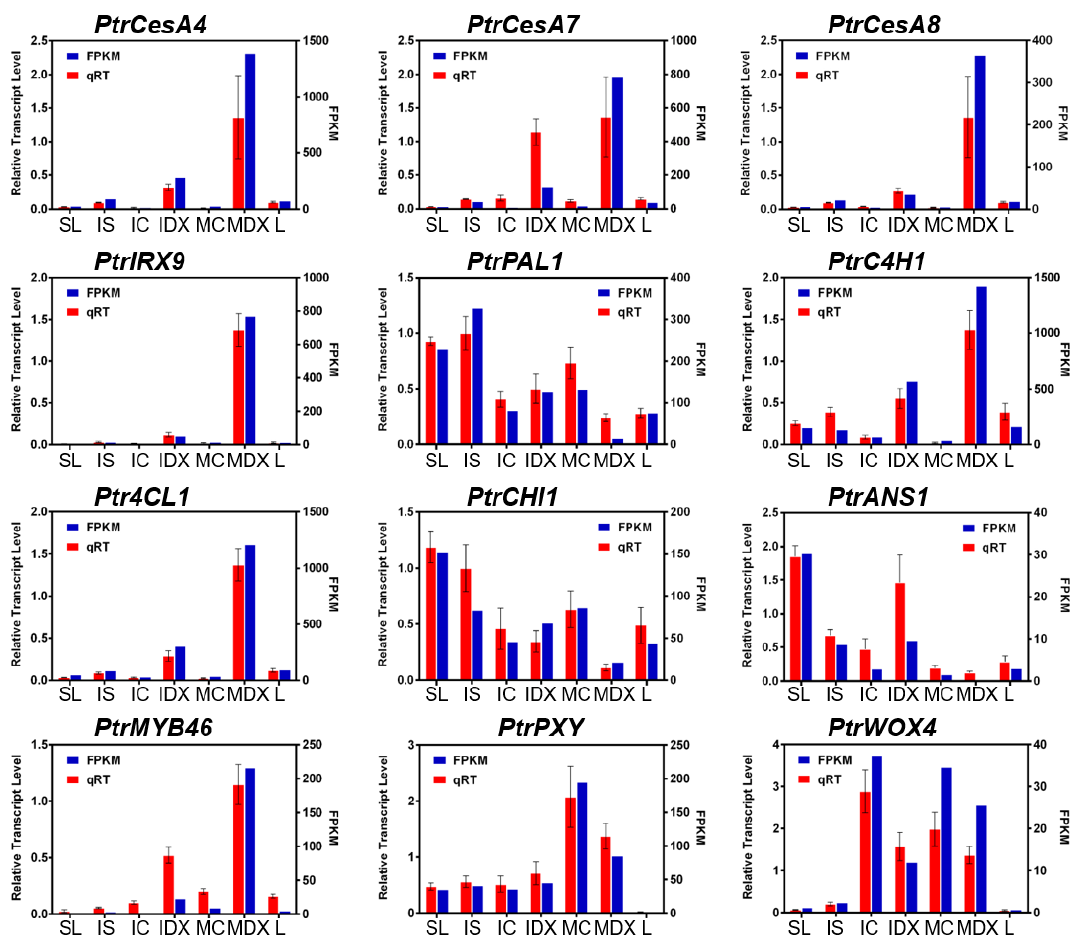
Figure 2. Confirmation of RNA-seq results by independent qRT-PCR analysis. Expression of each indicated gene is plotted. In each plot, blue bars (right Y-axis) indicate FPKM (Fragment Per Kilobase of transcript per Million mapped reads) values from RNA-seq data while red bars (left Y-axis) indicate qRT-PCR results. A gene model name for P. trichocarpa (v3.0) is shown in parenthesis as: PtrCesA4 (Potri.002G257900.1); PtrCesA7 (Potri.018G103900.1); PtrCesA8 (Potri.011G069600.1); PtrIRX9 (Potri.016G086400.1); PtrPAL1 (Potri.006G126800.1); PtrC4H1 (Potri.013G157900.1); Ptr4CL1 (Potri.001G036900.1); PtrCHI1 (Potri.010G213000.1); PtrANS1 (Potri.003G119100.1); PtrMYB46 (Potri.009G053900.1); PtrPXY (Potri.003G107600.1); and PtrWOX4 (Potri.014G025300.1). PtrActin2 (Potri.019G010400.1) was used as a reference gene. Error bars indicate S.E. gene-specific primer sequences used in this analysis are shown in Table S2.